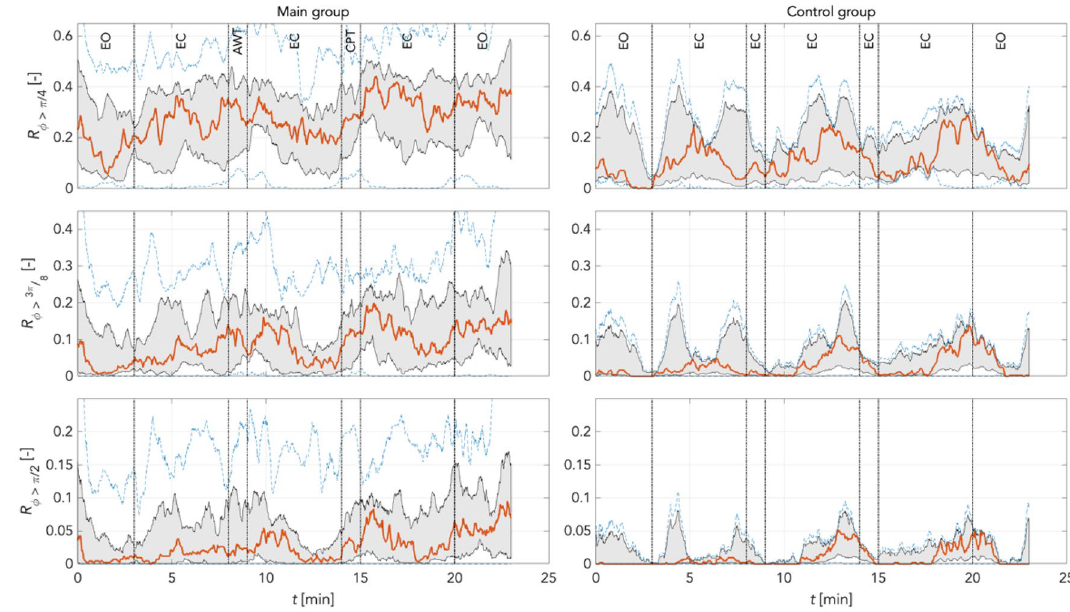
Figure 15. Phase desynchronization for different thresholds for main and control groups in the LF_Pf band (0.05 Hz – 0.1 Hz) possibly curtailing 0.1 Hz activity. In the main group, few pronounced oscillations; the level of phase desynchronization decreased with each threshold. Comparable course of phase desynchronizations in all thresholds for CPT: stable course during CPT, rapid increases, slow decreases for about 3 min. Few differently pronounced oscillations of shorter frequency and amplitude in all 3 thresholds. EO (stage 7) accompanied by hardly any changes in phase desynchronization. Stable conditions in the control group: distinct oscillations approx. every 7 min, most pronounced at π/4 > 3π/8 > π/2 rad. No evidence of increases in phase desynchronization with time. Red: median curve, black vertical lines: stages of the experiment, grey area bounds: 25 th and 75 th percentiles; blue dashed lines: min and max values.